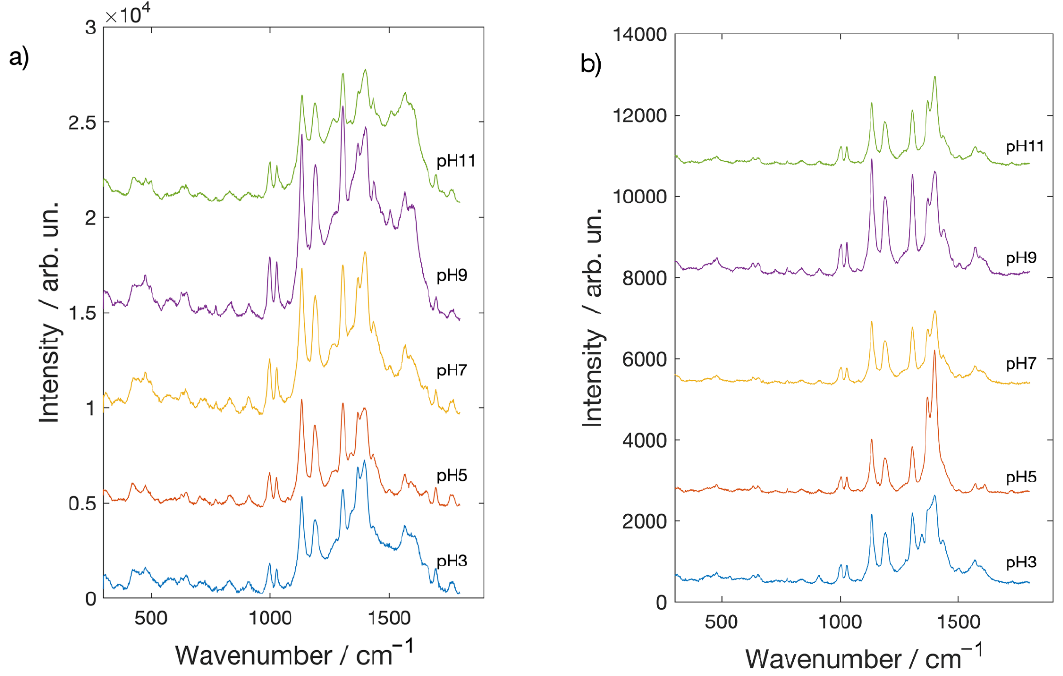
Figure 7. SERS spectra of Brazilwood acquired on polishing sheets coated with ( a ) Ag NPs and ( b ) Au NPs.